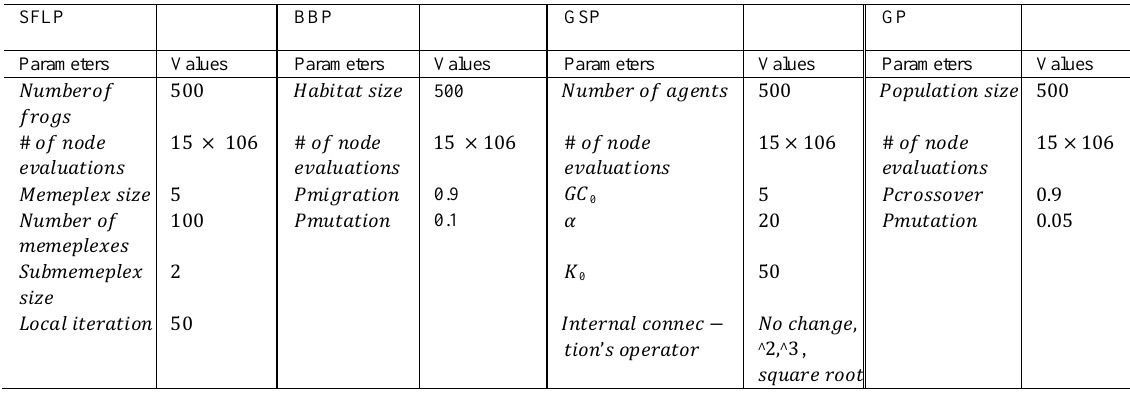
Table 3. Algorithms internal parameter.